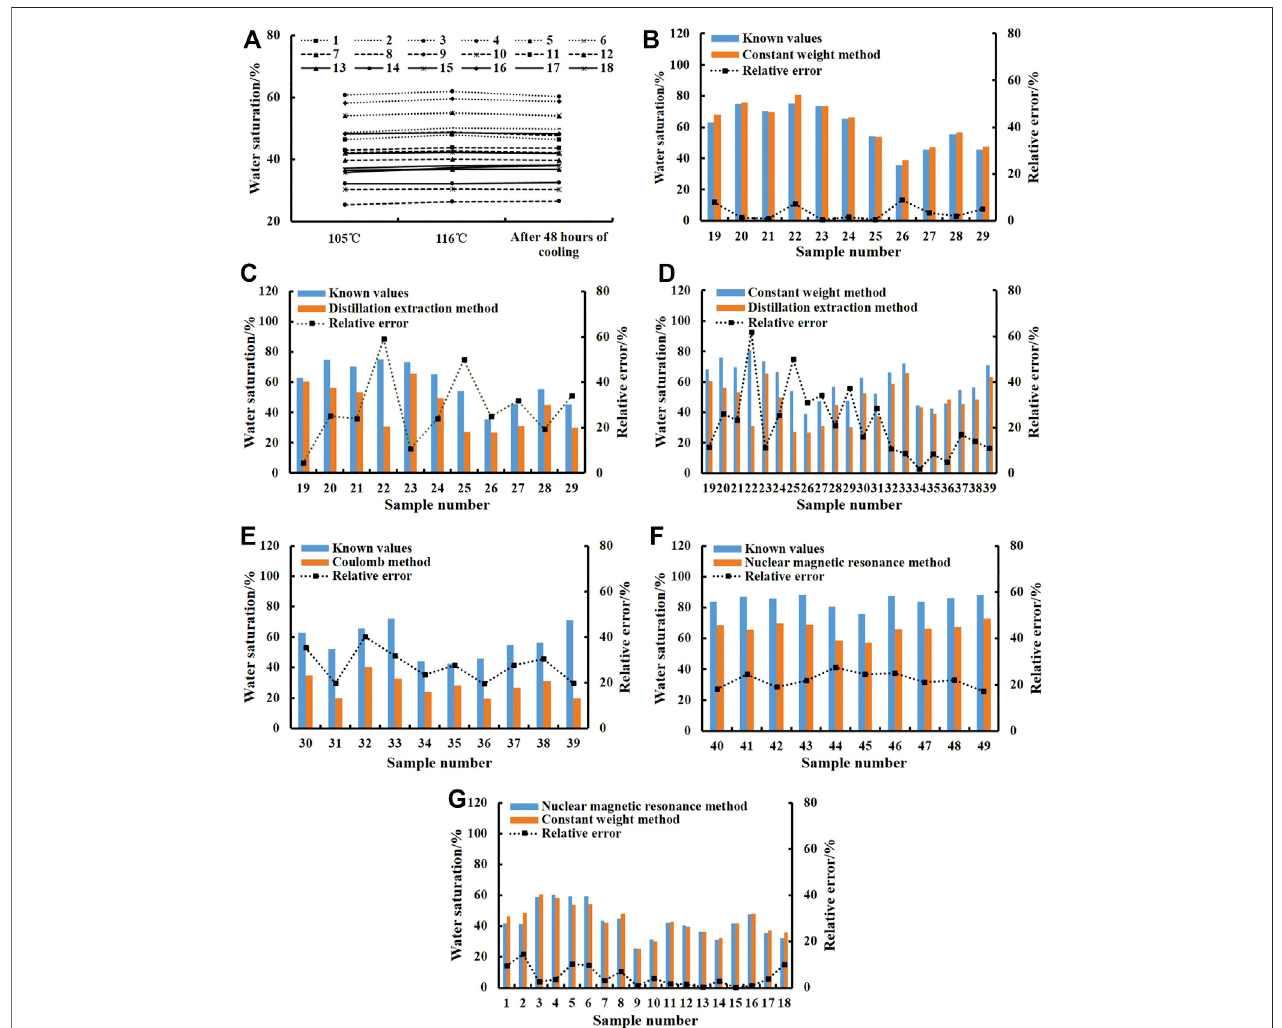
FIGURE 2 | The test results of water saturation by different methods: (A) the relationship of drying temperature and water saturation, (B) constant weight method, (C) distillationextractionmethod, (D) distillationextractionmethodvs.constantweightmethod, (E) Coulombmethod, (F) thewatersaturationtesterrorofcorebasedon normal NMR, and (G) the water saturation test error of core based on the optimized nuclear magnetic resonance method.